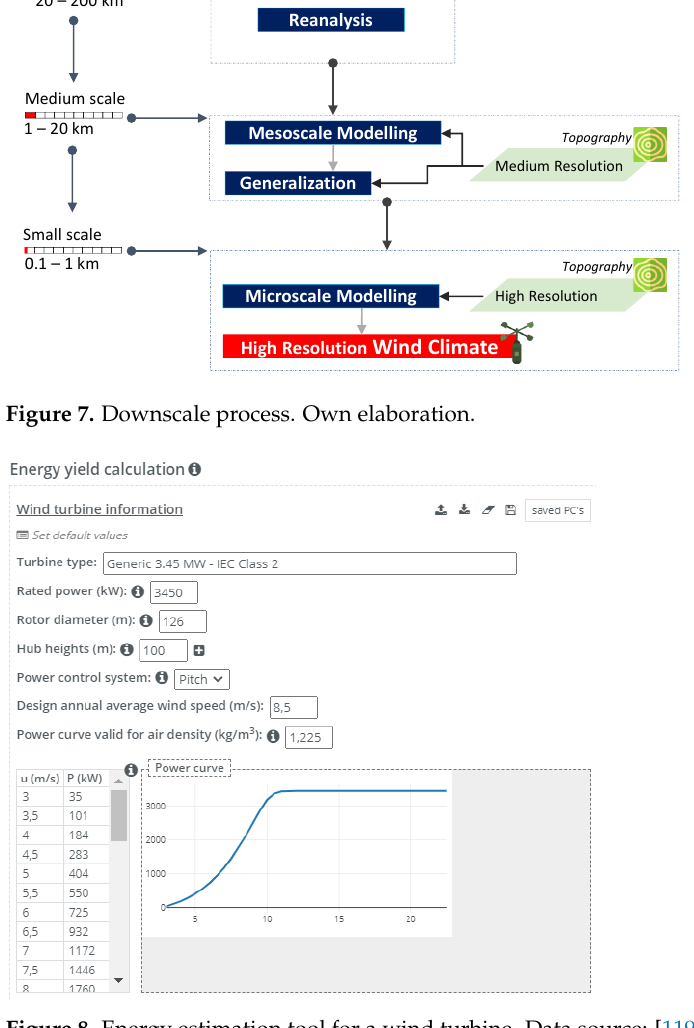
Figure 8. Energy estimation tool for a wind turbine. Data source: